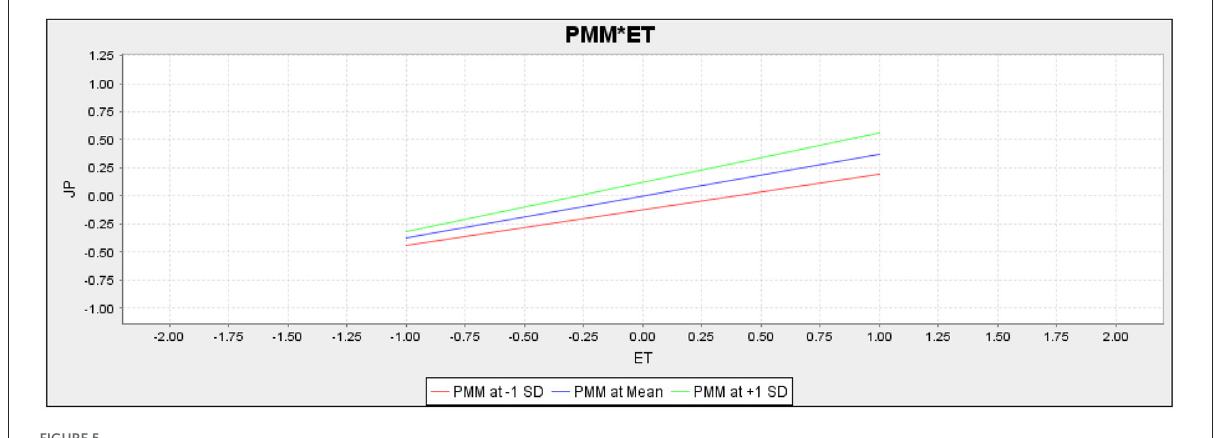
FIGURE5 Moderation slope of PMM *